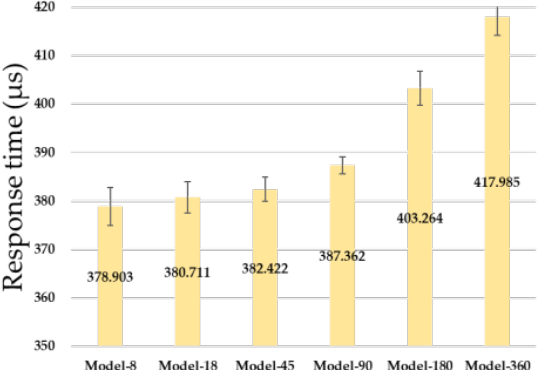
Figure 12. Response Time of six Neural Network Models.